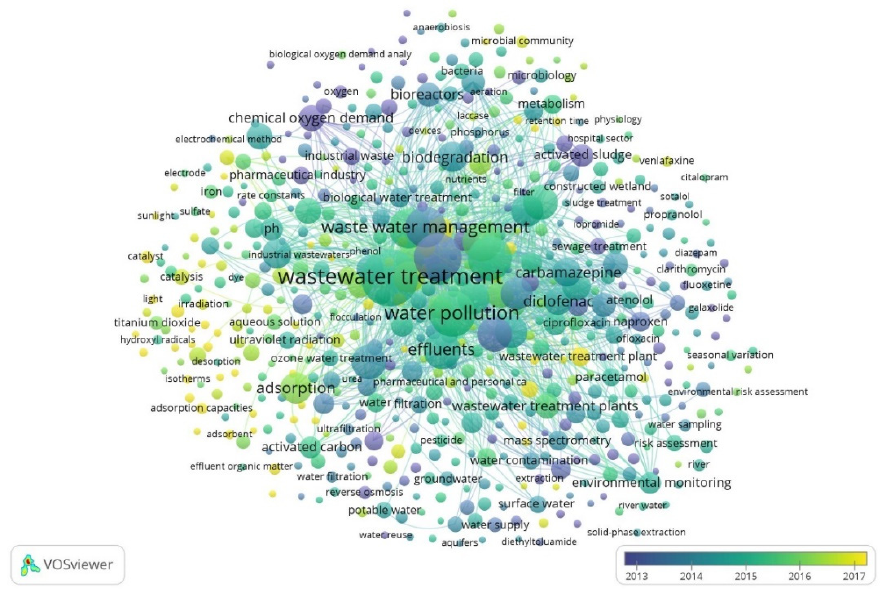
Figure 5. Timeline for main keywords used.